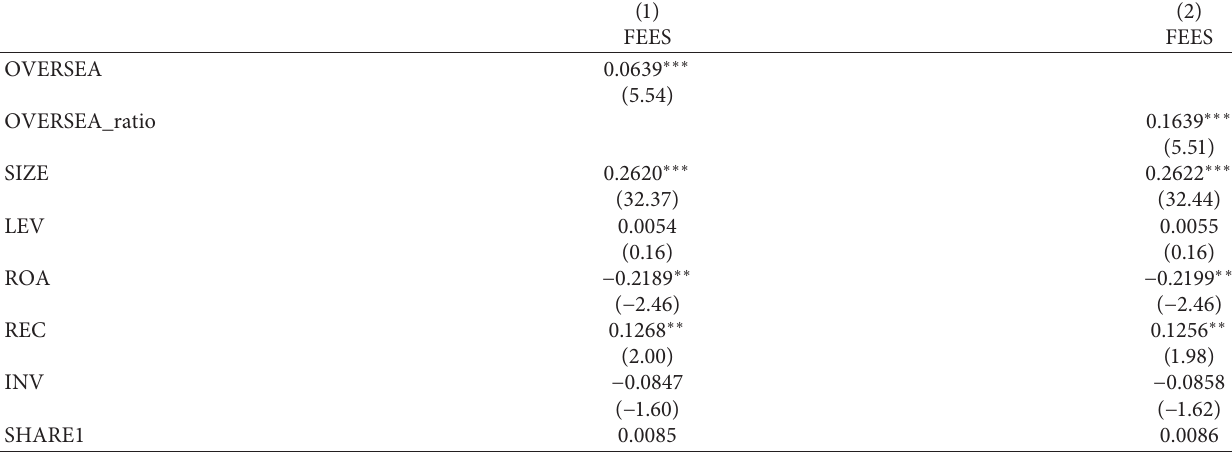
Table 11: Other characteristic variables of the audit